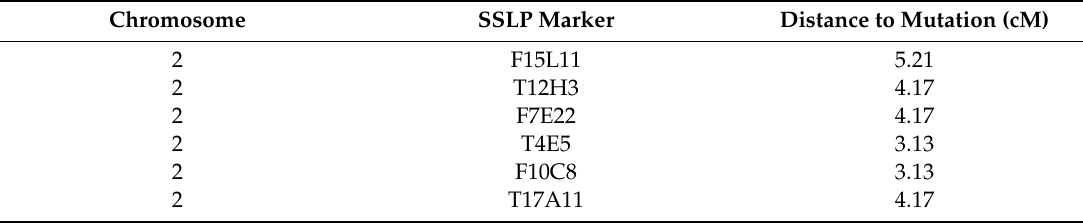
Table 5. Marker-assisted mapping of ewe2